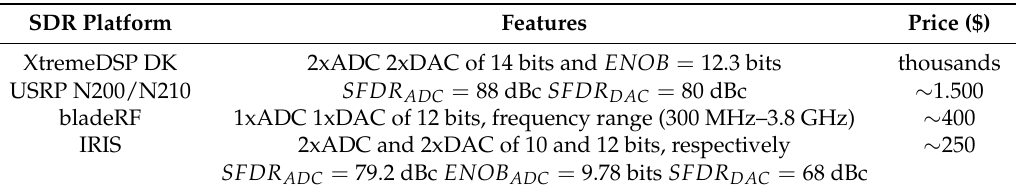
Table 7. Feature and price comparison among different integrated SDR